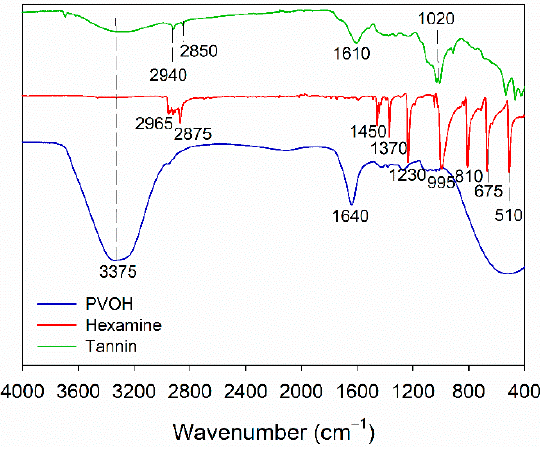
Figure 2. FTIR spectra of PVOH, tannin, hexamine. Table 3. Basic properties of PVOH–lignin–hexamine (PTH)-based adhesive.